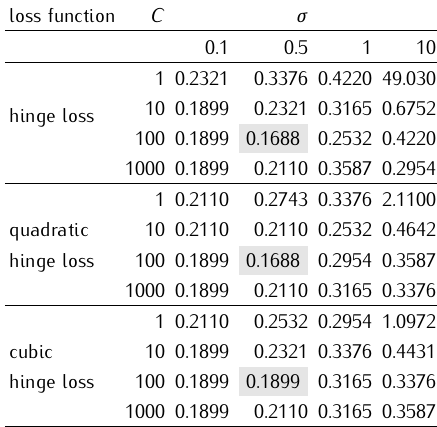
Table 1. Average classification errors over ten folds in percentage of the number of images contained in the test sets.